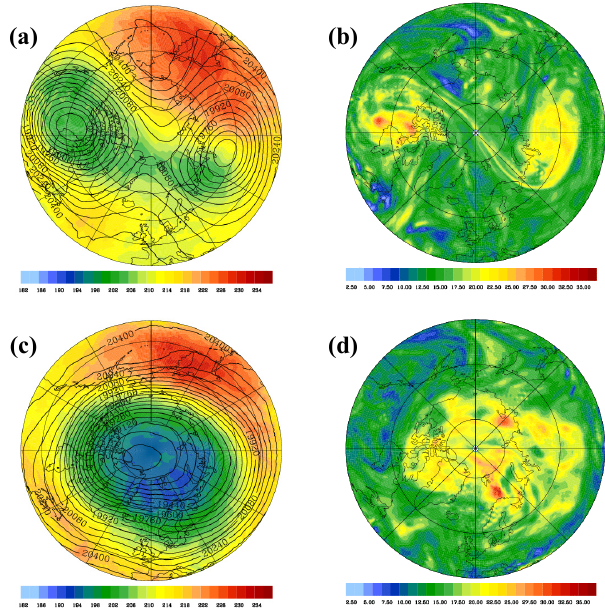
Fig. 2. Panels (a) and (c) : absolute Temperature (K, colour shaded) and geopotential height (m; black contour lines) at the 50hPa pres- Figure 2 : Panels (a) and (c): Absolute Temperature (K, colour shaded) and geopotential 4 sure surface. Panels (b) and (d) : scaled or modified potential vor- height (m; black contour lines) at the 50 hPa pressure surface. Panels (b) and (d): Scaled or 5 ticity PV · (2 /420K) − 9 / 2 (PVU; colour shaded) at 2 = 425K (see modified potential vorticity PV·( Θ /420 K) -9/2 (PVU; colour shaded) at Θ = 425 K (see Lait, 6 Lait, 1994). Operational ECMWF analyses interpolated at a regular 1994). Operational ECMWF analyses interpolated at a regular 0.5 ° x 0.5 ° latitude/longitude 7 0 . 5 × 0 . 5 ◦ latitude/longitude grid for 10 December 2009 (a, b) and 9 January 2010 (c, d) grid for 10 December 2009 (a,b) and 9 January 2010 (c,d). 8